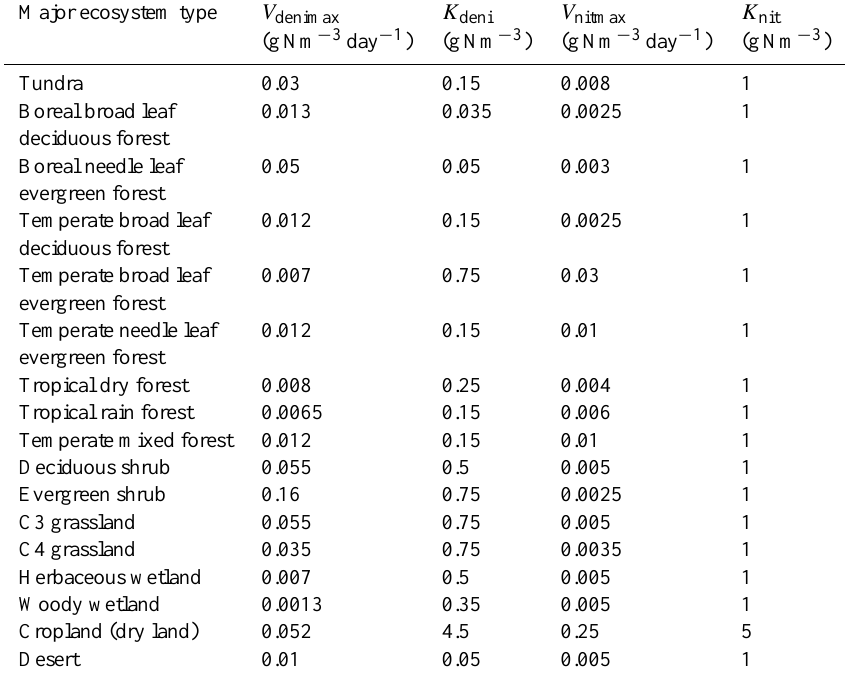
Table 5. Values of the major parameters for different ecosystem types in nitrous oxide module after the Bayesian